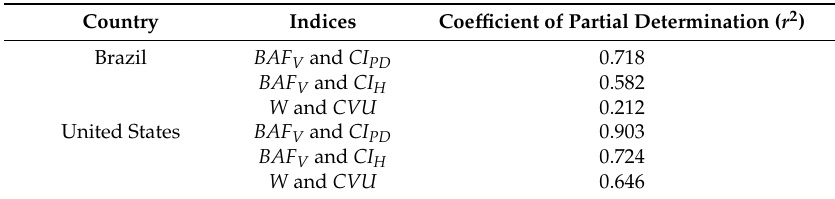
Table 4. Coefficients of partial determination for selected competition indices and the BAF V